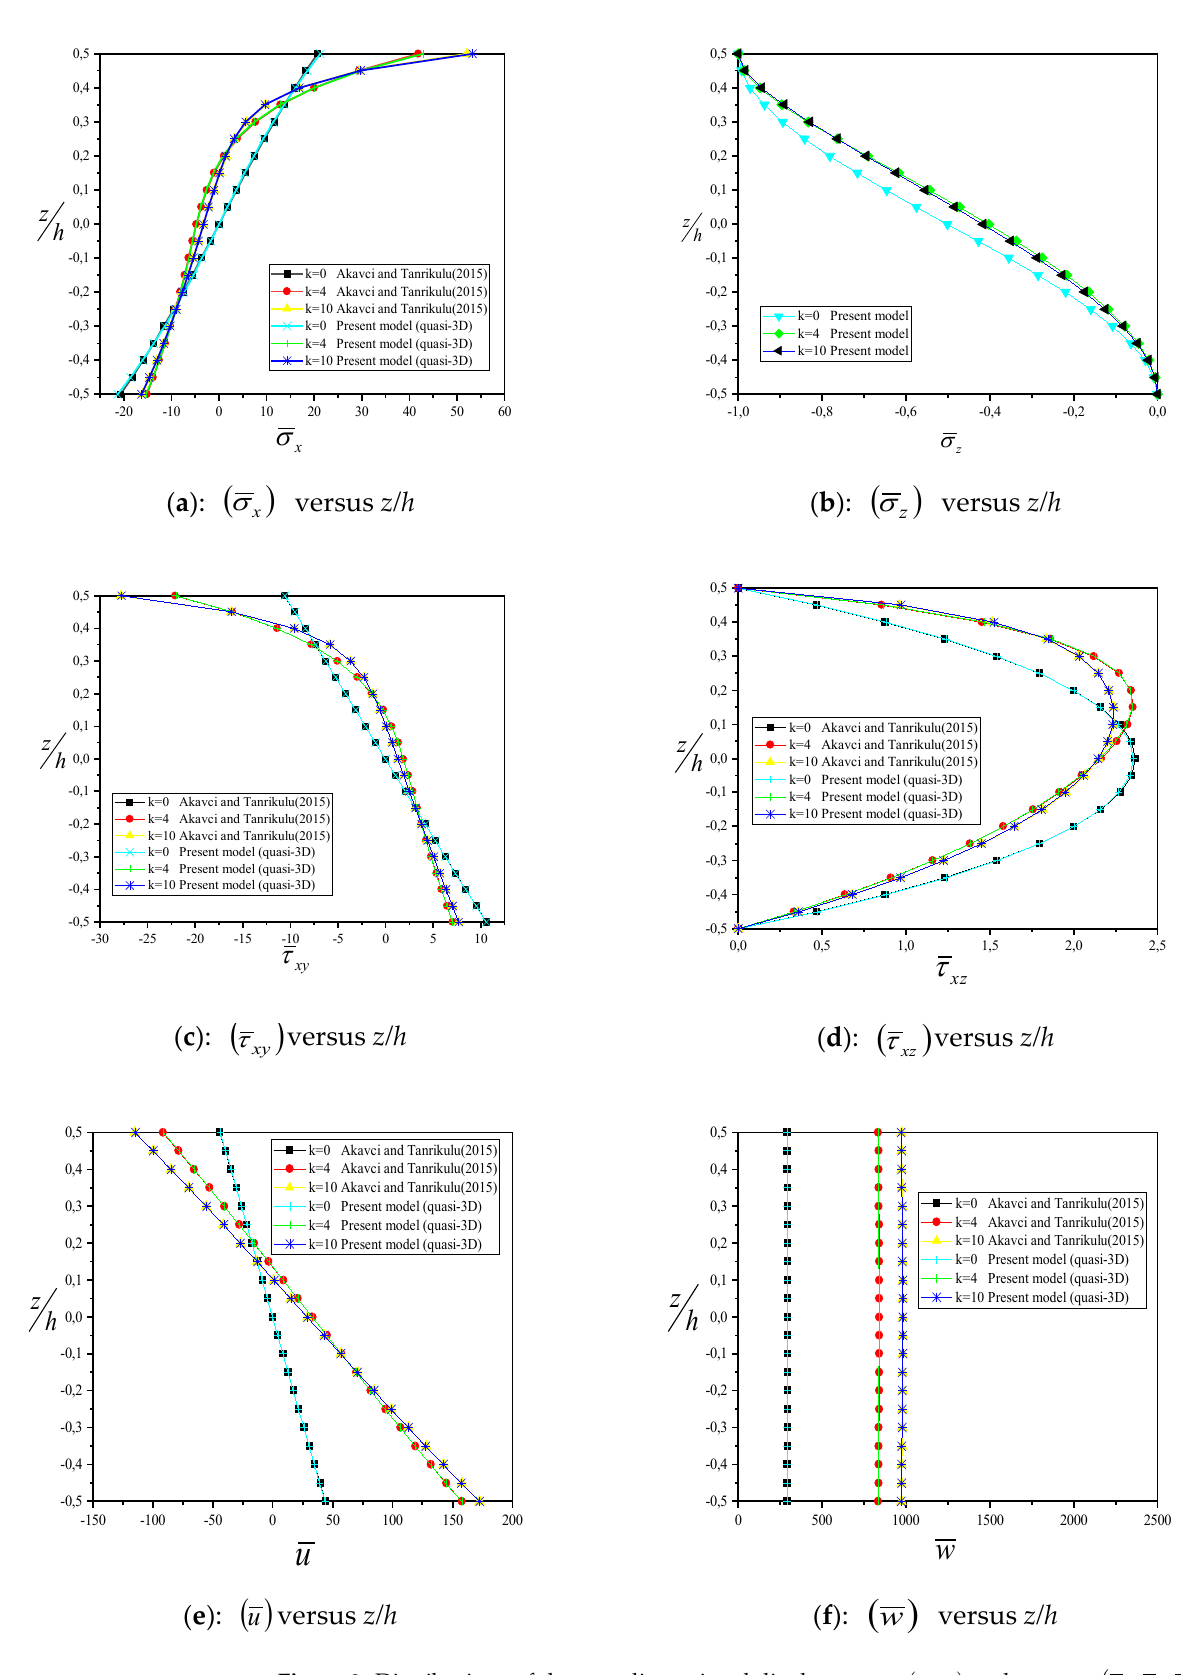
Figure 2. Distributions of the non-dimensional displacements ( u , w ) and stresses ( ) ττσσ ,,, through the thickness of square P − GM plate ( a / h = 10) [31]. xzxyzx In the middle of the FG plate, the axial stresses are negative in the lower half of the metal for all values of the power index k and then become positive in the upper part starting from the geometric ratio z / h > 0.17. Beyond this value, the stresses tend to increase